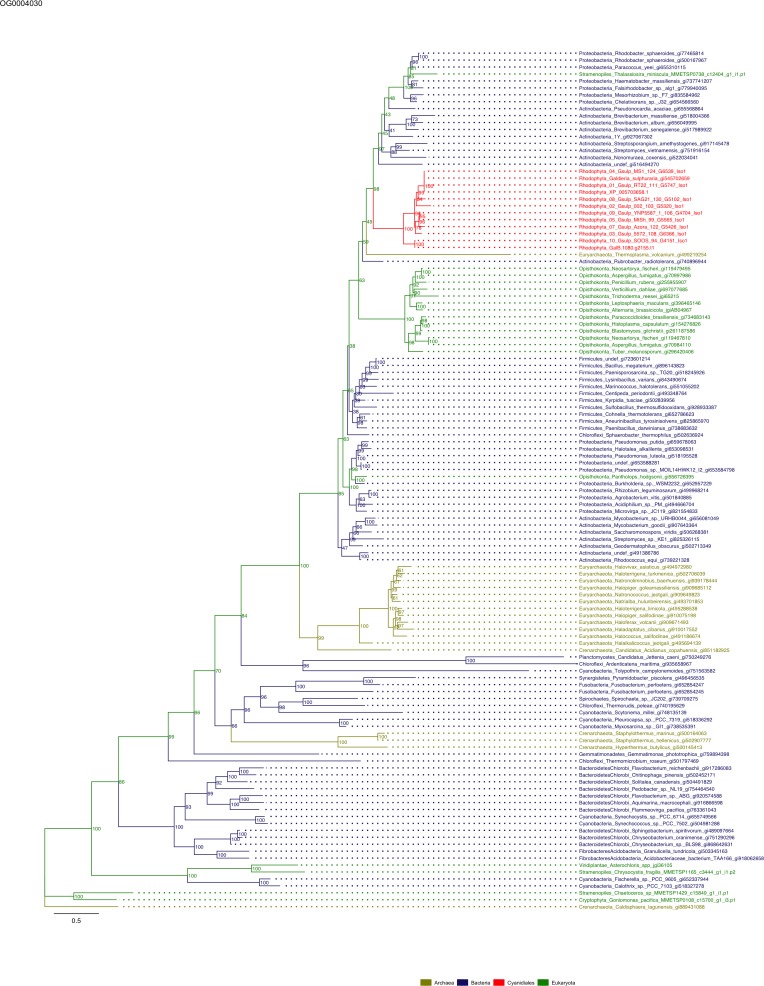
Sequence tree of orthogroup OG0004030.The tree is based on amino acid sequences. Archaea (yellow), Bacteria (blue), Cyanidiales (red), Eukaryotes including other red algae (green). Branches containing Cyanidiales sequences are highlited in red.